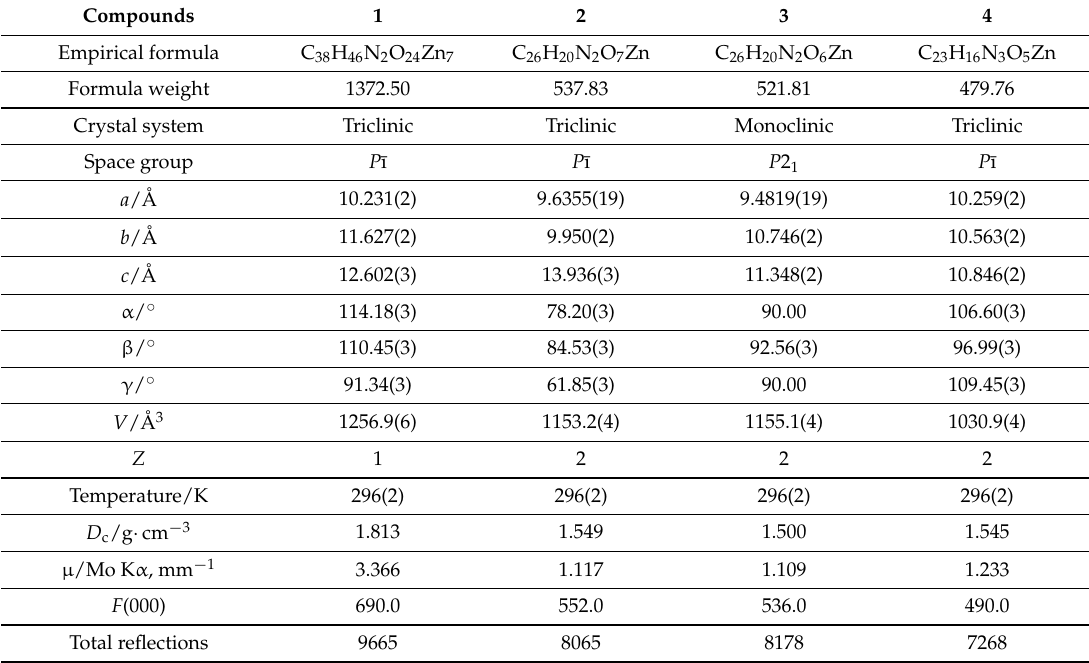
Table 1. Summary of crystallographic data for 1 – 4